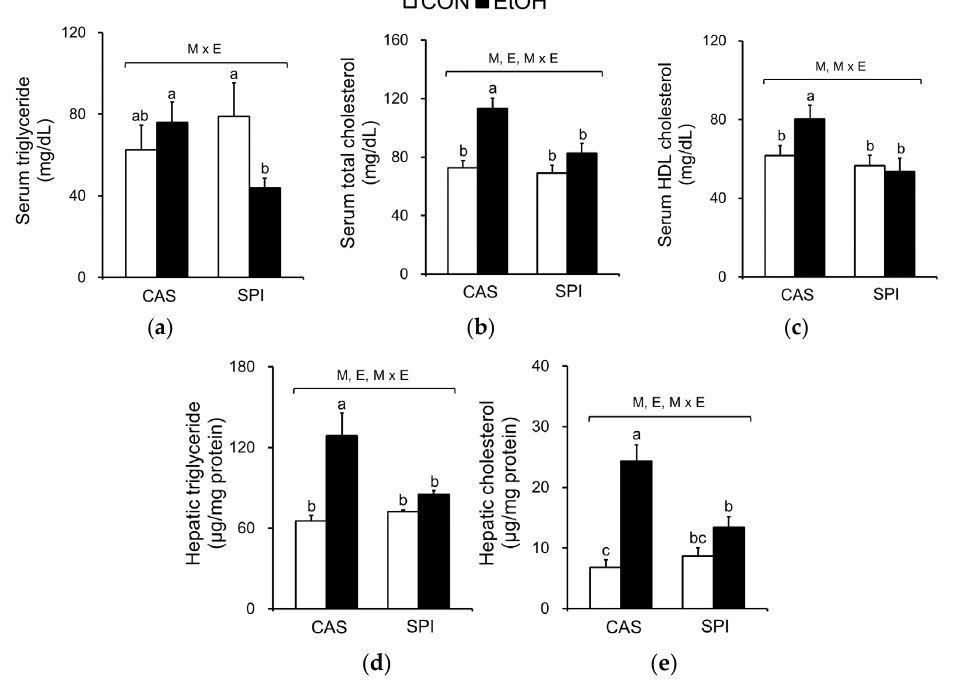
Figure 5. Effects of maternal diet on serum and hepatic lipid levels in adult offspring fed an ethanol diet. Serum ( a ) triglyceride, ( b ) total cholesterol, and ( c ) HDL cholesterol levels ( n = 8); Hepatic ( d ) triglyceride and ( e ) cholesterol levels ( n = 7 ‒ 8). Data are expressed as means ± SEM. Significant effects of maternal diet (M), offspring ethanol diet (E), and their interaction (M × E) were analyzed by two ‐ way ANOVA ( p < 0.05). Means without a common superscript significantly differ based on post ‐ hoc analysis ( p < 0.05). Data that were not normally distributed were log ‐ transformed before the statistical analysis. CAS, casein; SPI, low ‐ isoflavone soy protein isolate; CON, control; EtOH, ethanol.